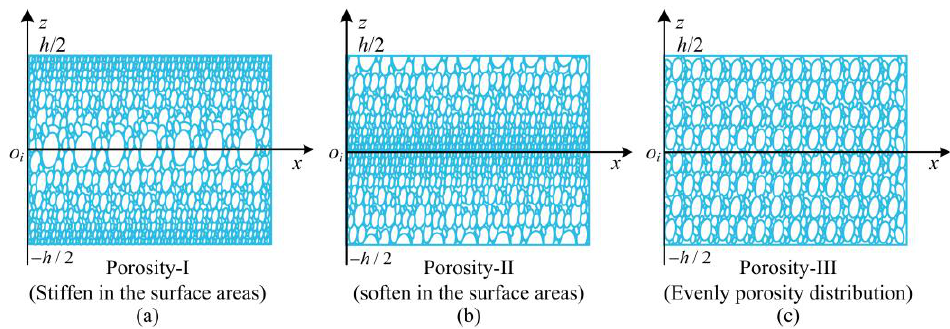
Figure 2. Cross-section of a single GPLRP, cylindrical panel for different porosity distributions. ( a ) Porosity-I; ( b ) Porosity-II; ( c ) Porosity-III .